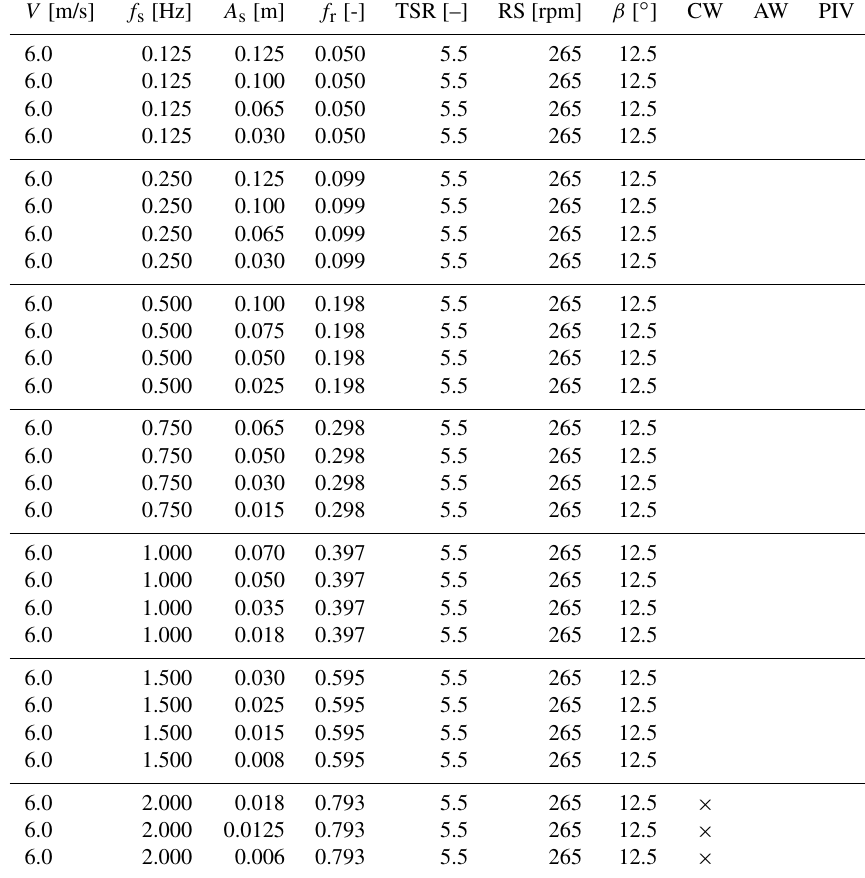
Table B3. ABOVE test matrix. V is the mean wind speed, f s the surge frequency, A s the surge amplitude, f r the reduced frequency, TSR tip-speed ratio, RS the rotor speed, and β the blade pitch angle. The CW, AW, and PIV columns indicate whether a cross-wind, along-wind, or PIV measurement of the wake was carried